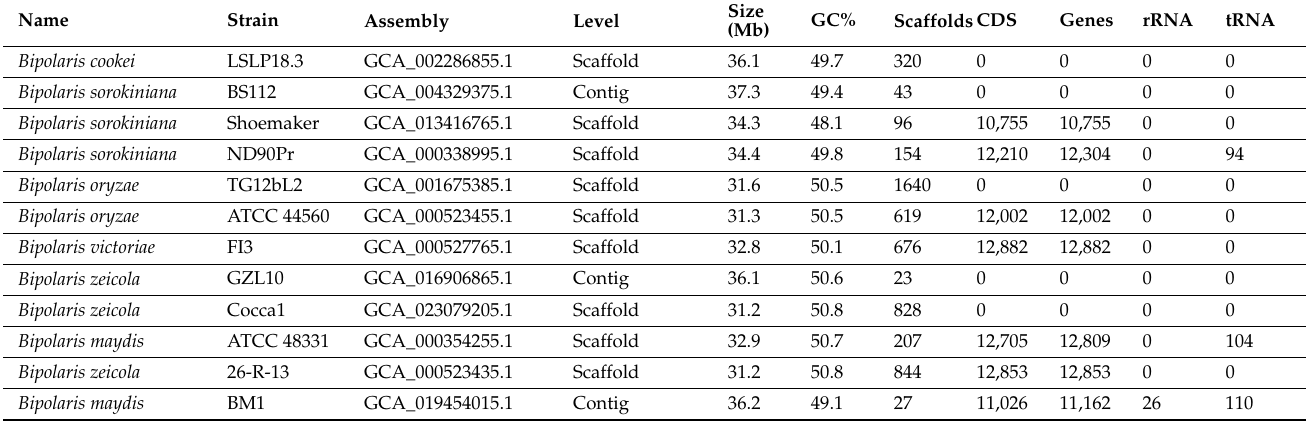
Table 7. Whole genome sequences of Bipolaris and Curvularia species available in the NCBI